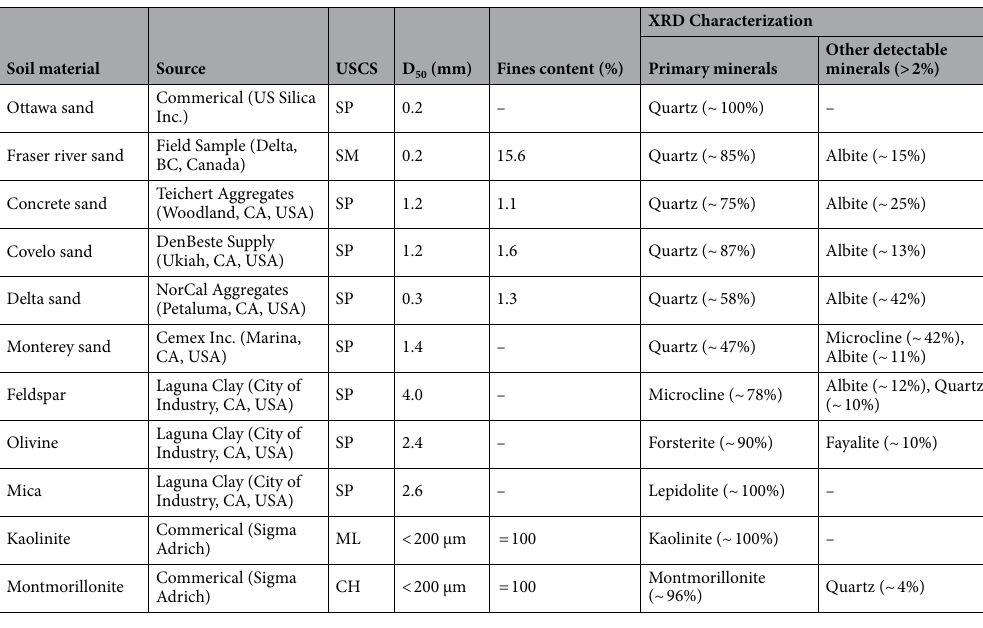
Table 2. Summary of all tested soil